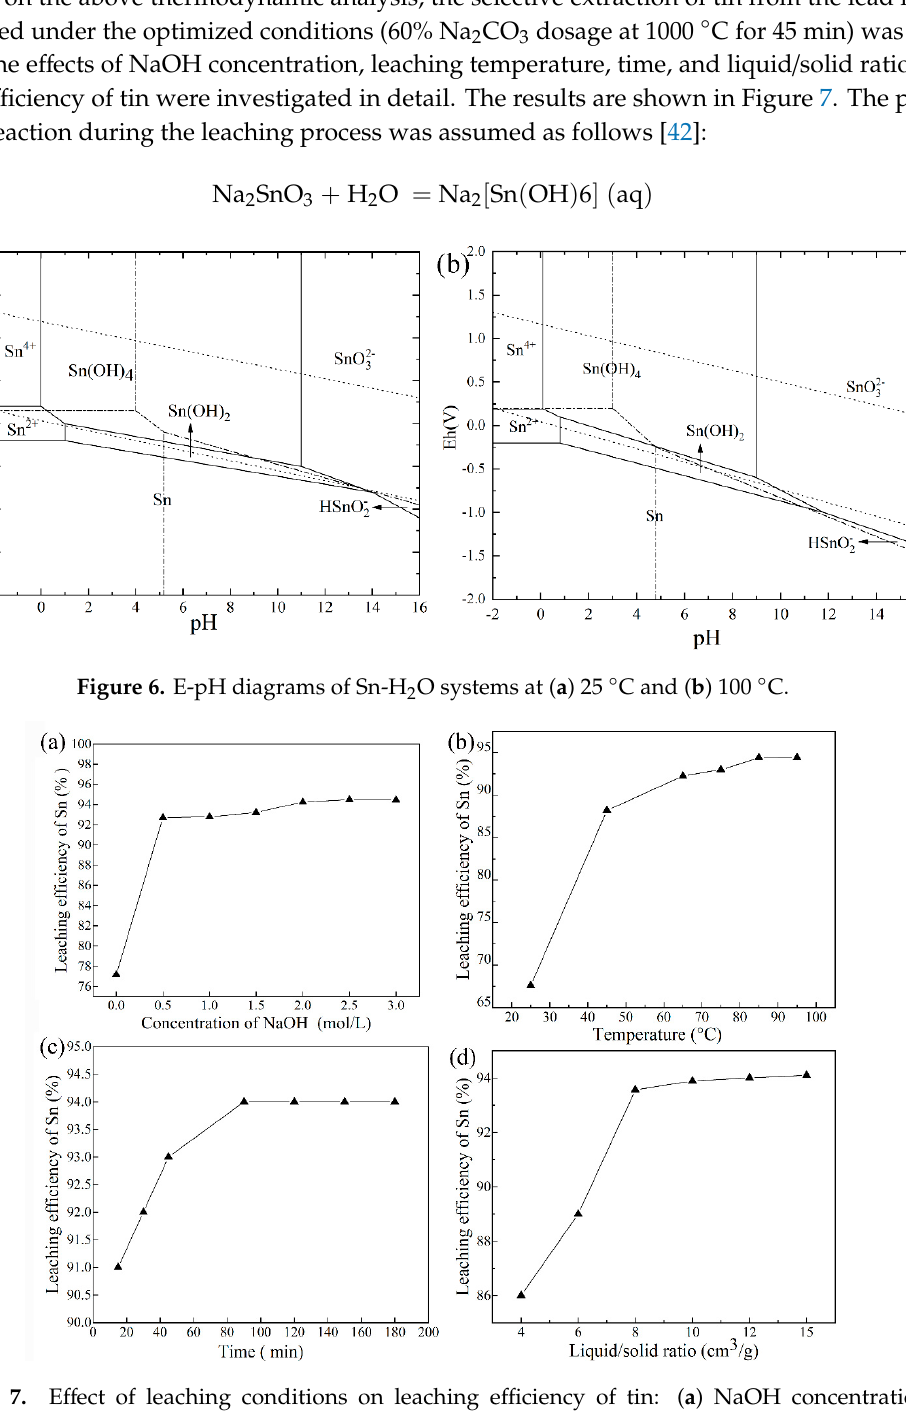
Figure 7. Effect of leaching conditions on leaching efficiency of tin: ( a ) NaOH concentration; ( b ) temperature; ( c ) time; ( d ) liquid/solid ratio. ( b ) temperature; ( c ) time; ( d ) liquid / solid